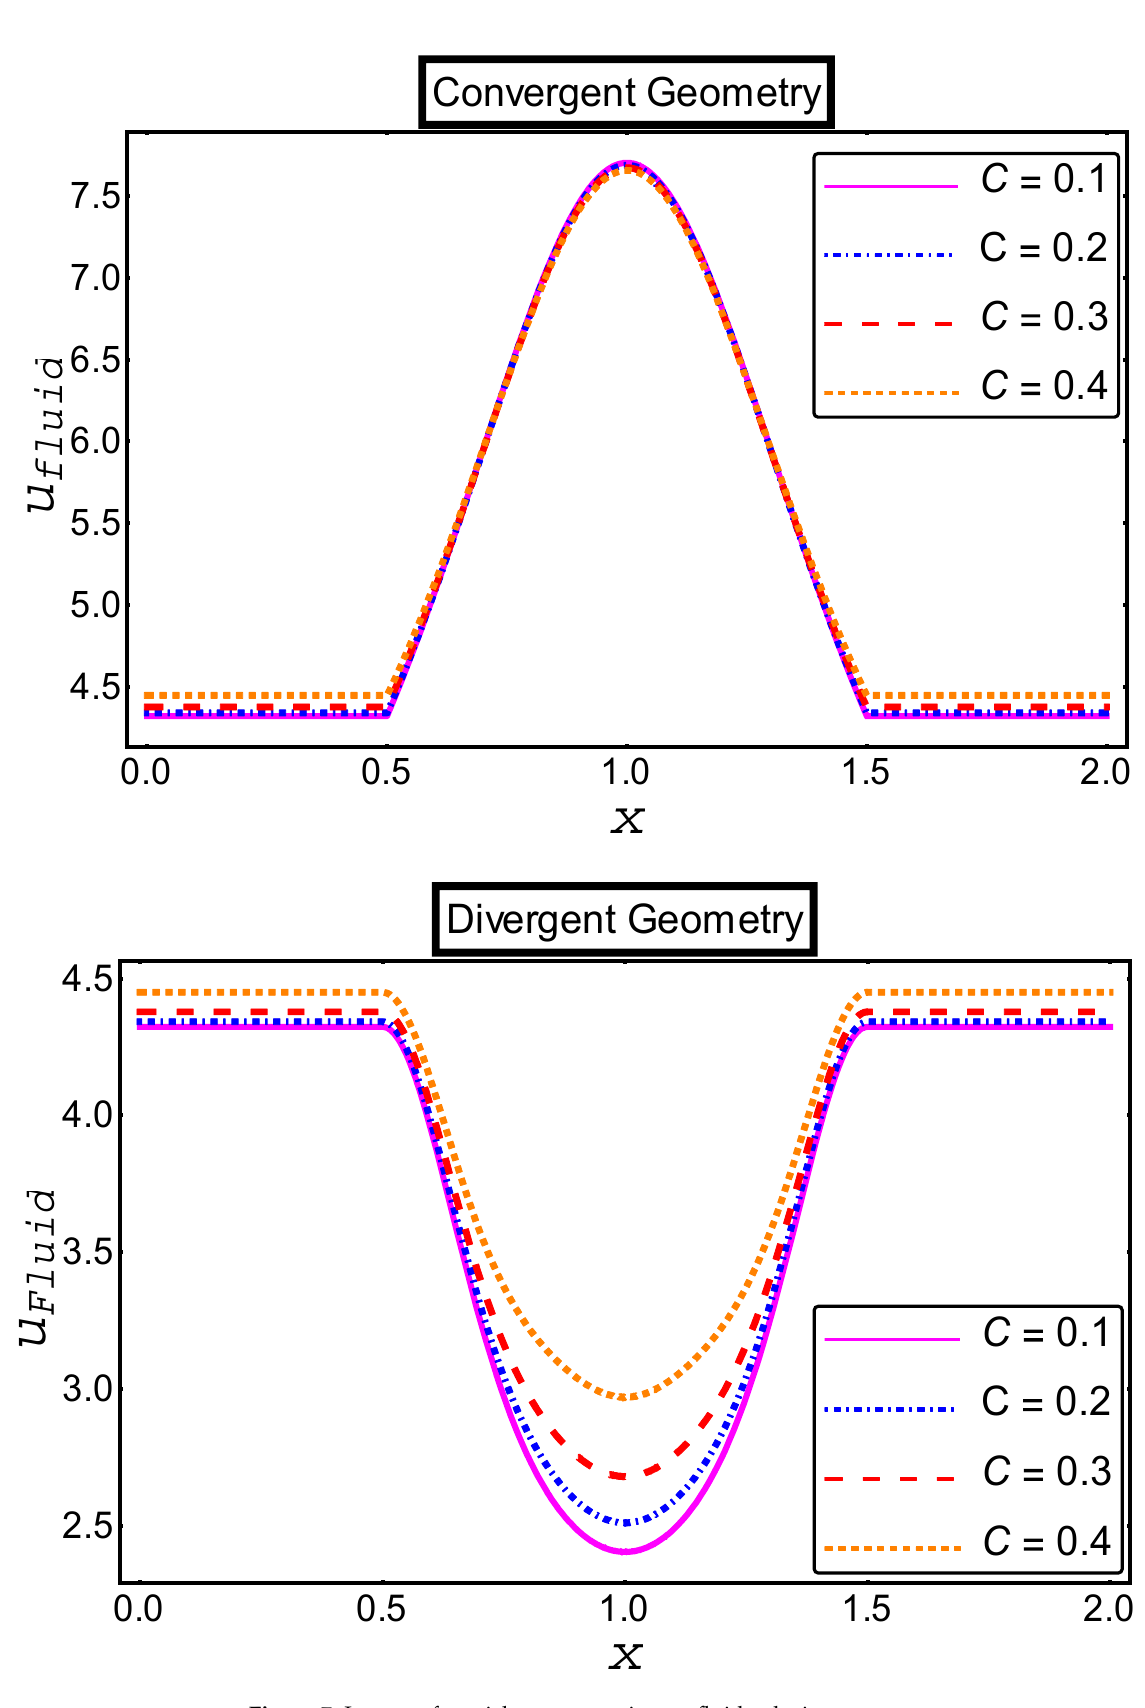
Figure 7. Impact of particle concentration on fl uid velocity.